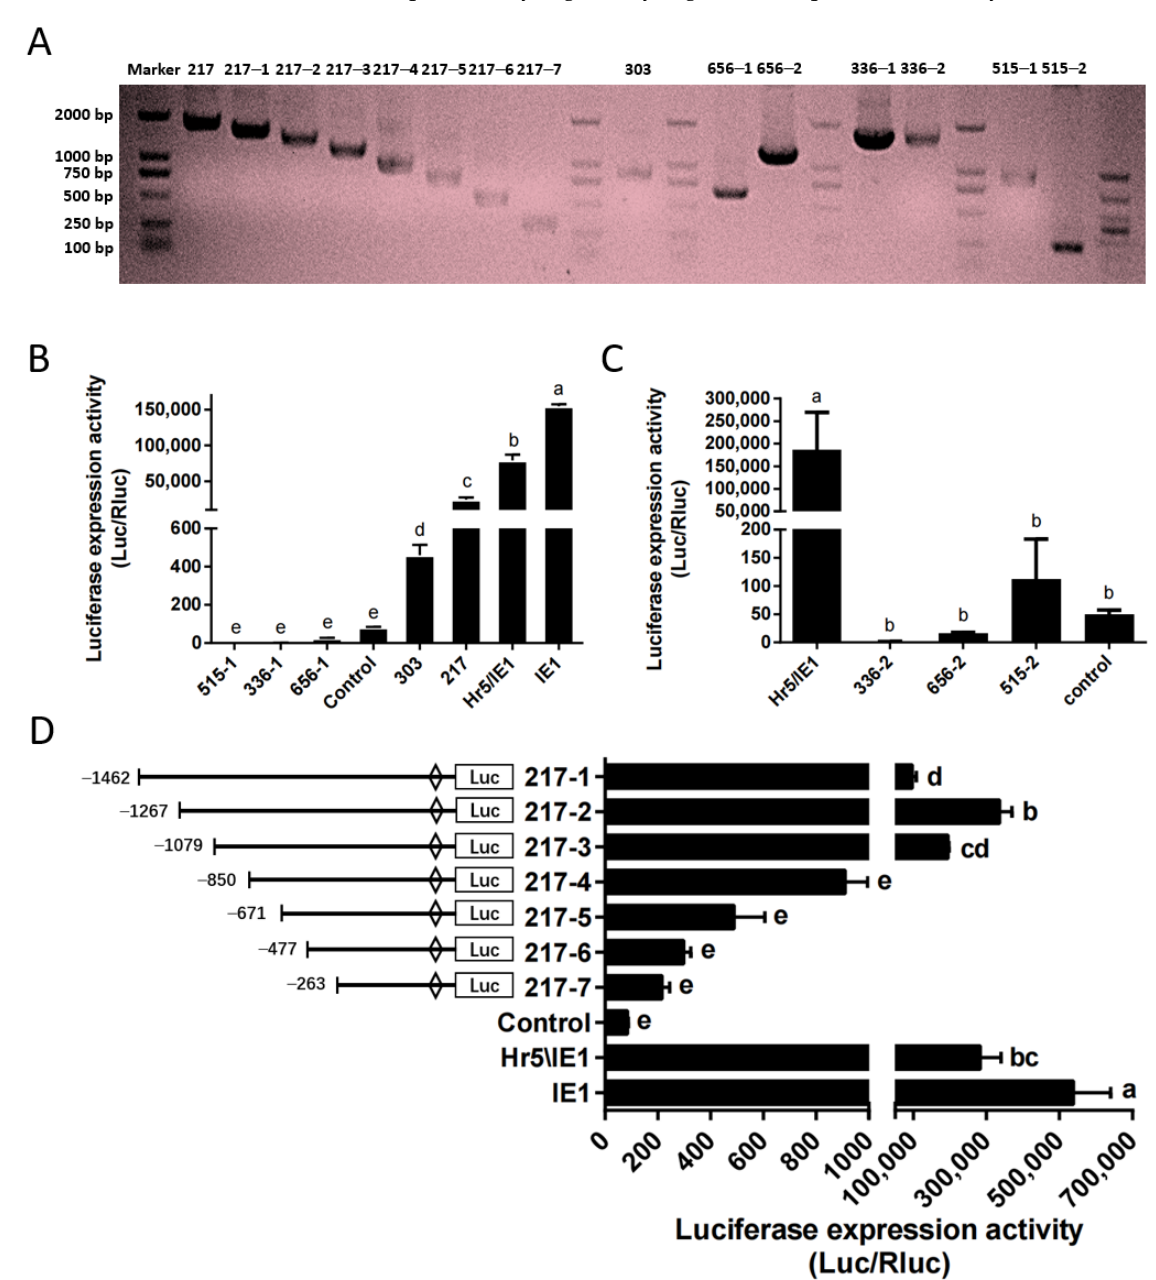
Figure 3. Amplification and efficiency identification of the P. xylostella endogenous promoters. ( A ) Amplification of endogenous promoter and truncation of the 217 promoter. ( B , C ) Driving efficiency of the P. xylostella endogenous promoter, the significant difference between groups are indicated by lowercase letters (Duncan, p < 0.05). ( D ) Driving efficiency of the 217 promoter after truncation, the significant difference between groups is indicated by lowercase letters (Duncan, p < 0.05).